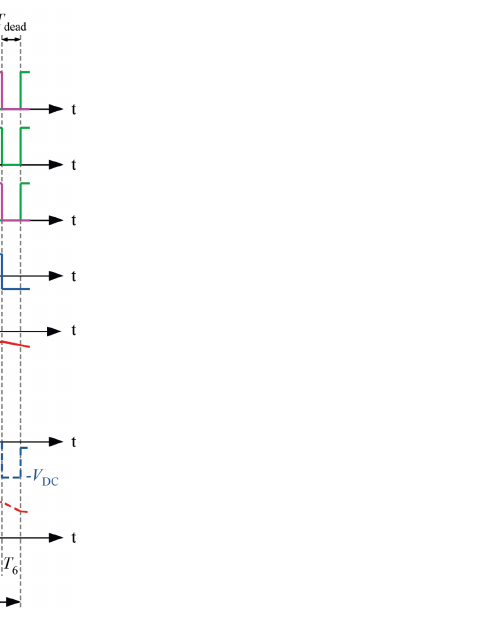
Figure 20. Active switch states, inductor voltages and inductor currents for FC2BDC Buck–Boost